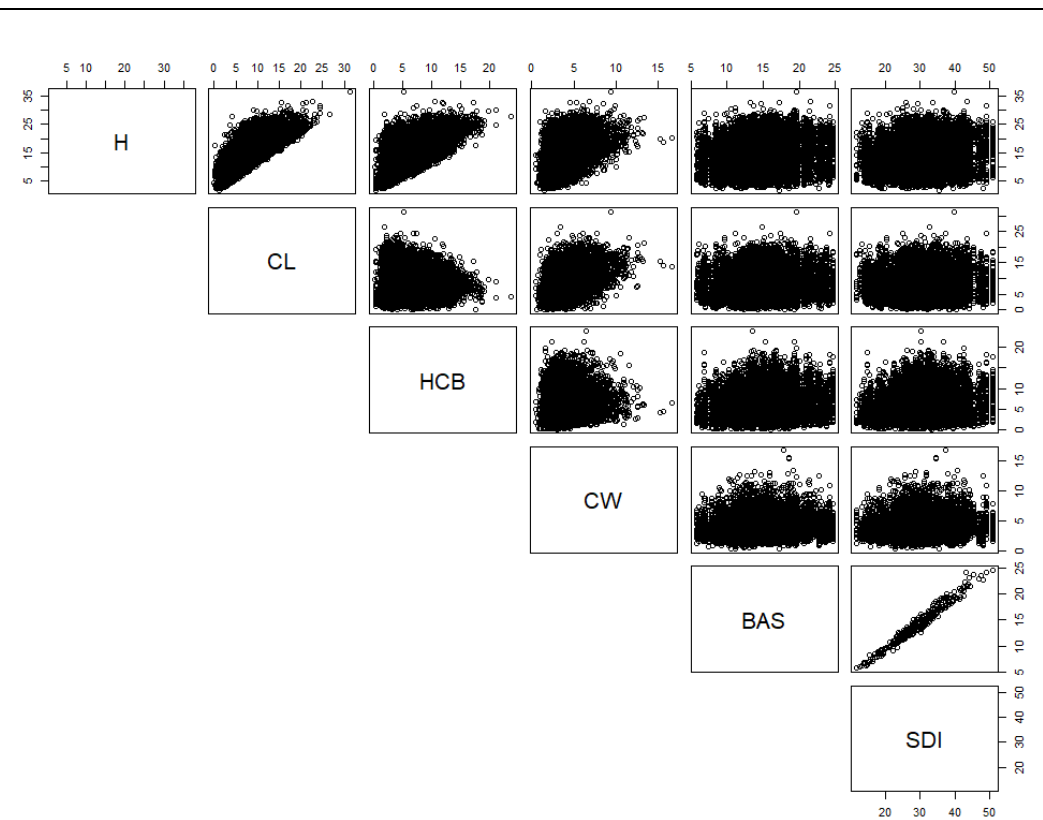
Figure 1. The relationships of individual tree H (total tree height), CL (crown length), HCB (height to live crown base) with individual tree factors, including D , Dg , and DT ( H : total tree height (m); CL : crown length (m); HCB : height to live crown base (m); D : diameter at breast height (cm); Dg : mean quadratic D (cm); DT : stand dominant D (cm).